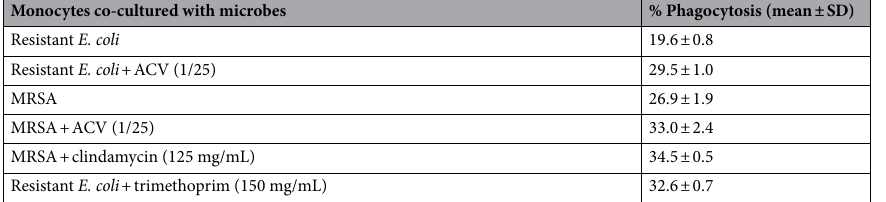
Table 2. Effect of ACV on human monocyte phagocytic capacity. In vitro differentiated macrophages were incubated with microbes for 4 h at 37 °C. Cells cultured with microbes with or without ACV were washed and processed for detection on the Beckton Dickinson flow cytometer. An analysis of changes in regional gated profiles and % shift in side scatter was measured. Data is presented as mean ± SD of 3 similar experiments.